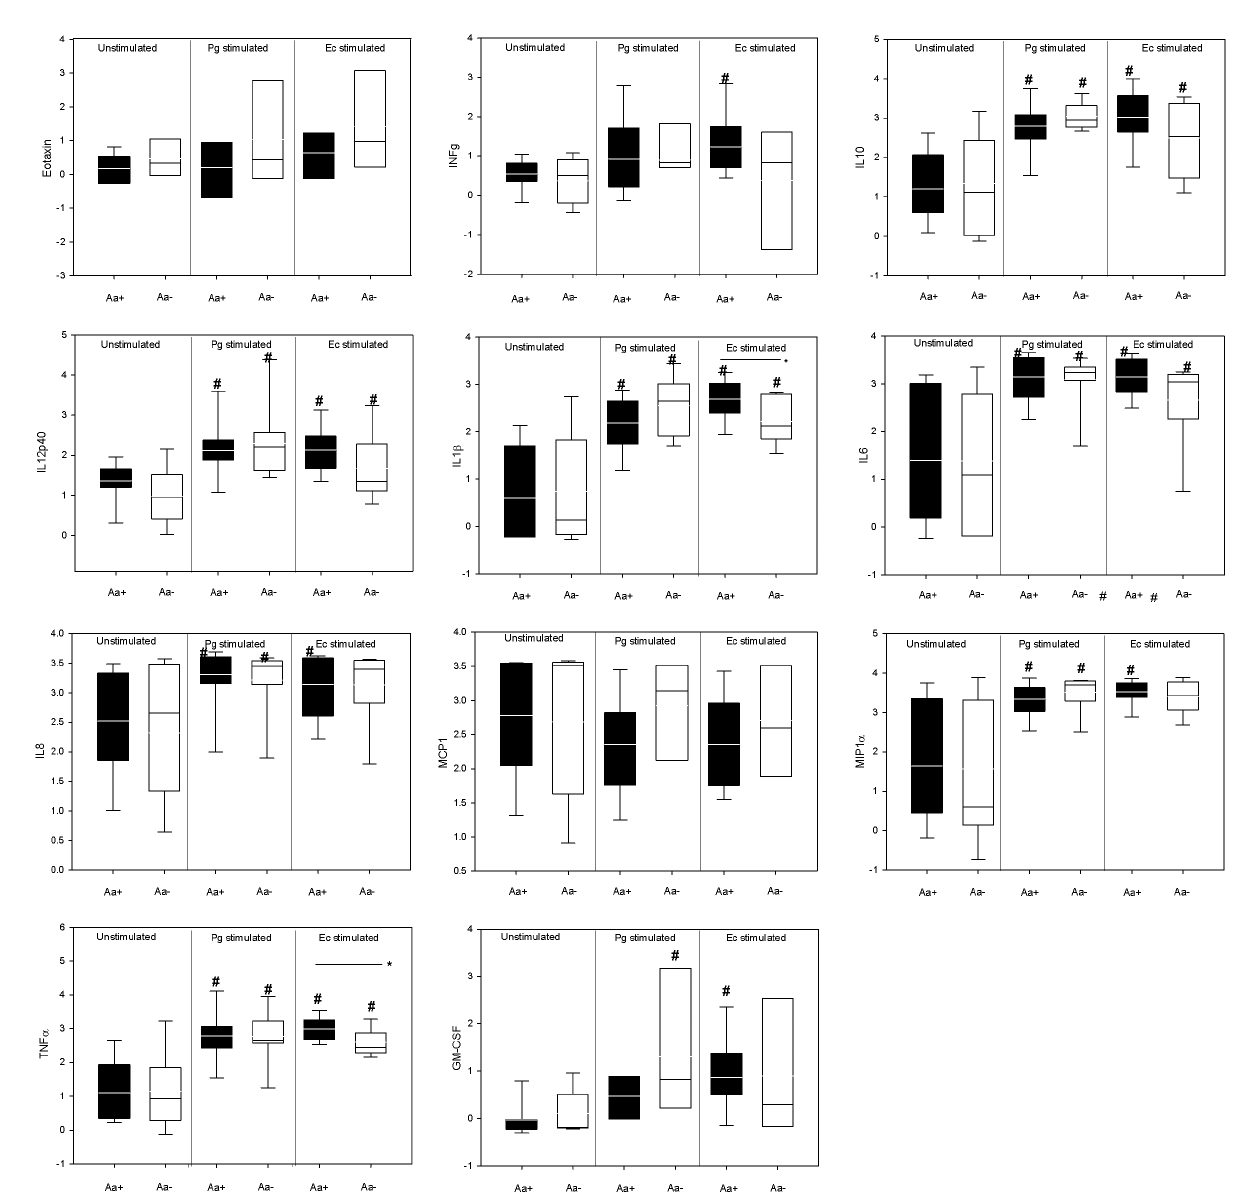
Figure 4. Systemic LPS-induced cyto/chemokine values in both groups. Values are reported as normalized log pg/mL. Box- plots show the mean (horizontal line), inter-quartile range (box), 5 th -95 th percentiles (vertical lines). *Indicates statistically significant differences between groups (Aa+ and Aa-) by t-test (p<0.05). # Indicates statistically significant differences within groups regarding TLR stimulation by One-way ANOVA